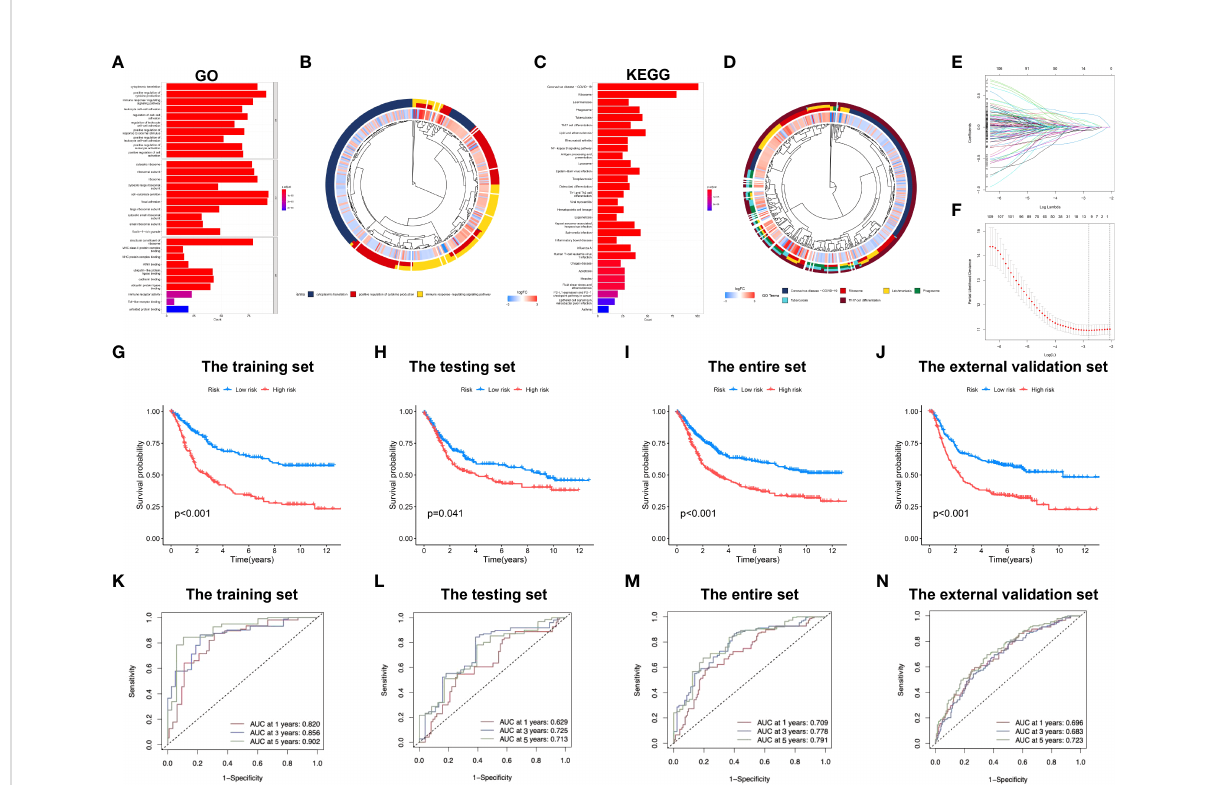
FIGURE 2 Development of the immune-related signature in the training set. (A) GO functional enrichment analysis of immune-related genes. (B) Concentric circle diagram of the GO analysis. (C) KEGG pathway analysis of immune-related genes. (D) Concentric circle diagram of the KEGG analysis. (E) LASSO coef fi cient curves are shown. (F) Selection of tuning parameters (lambda) in the LASSO model by tenfold cross-validation according to the minimum criterion of OS is displayed; the lower x-axis indicates the log (lambda) and the upper x-axis the average number of OS-gene. The y-axis represents the partial likelihood bias error. The red dots denote the average partial likelihood deviation for each model given the lambda, and the vertical bars indicate the upper and lower values of the partial likelihood deviation error. Kaplan-Meier survival curves of patients in low-risk group and high-risk group of the training set (G) , the testing set (H) , the entire set (I) , and the external validation cohort (J) are presented. (K – N) indicate survival-dependent ROC curves validation at 1-year, 3-year and 5-year of prognostic value of the signature in the four sets (the training set, the testing set, the entire set, and the external validation cohort, respectively). GO, Gene Ontology; KEGG, Kyoto encyclopedia of genes and genomes; LASSO, least absolute shrinkage and selection operator; OS, overall survival; ROC, receiver operating characteristic